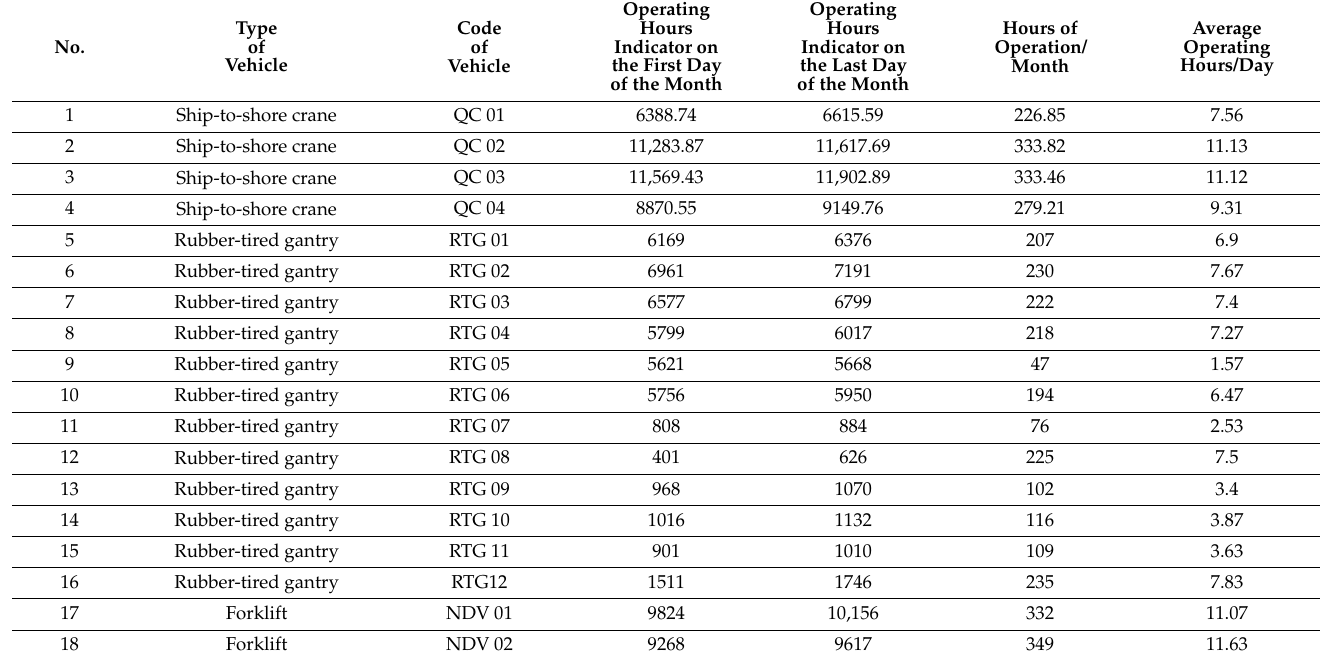
Table 3. Hours of operation/month of vehicle/equipment in Nam Dinh Vu